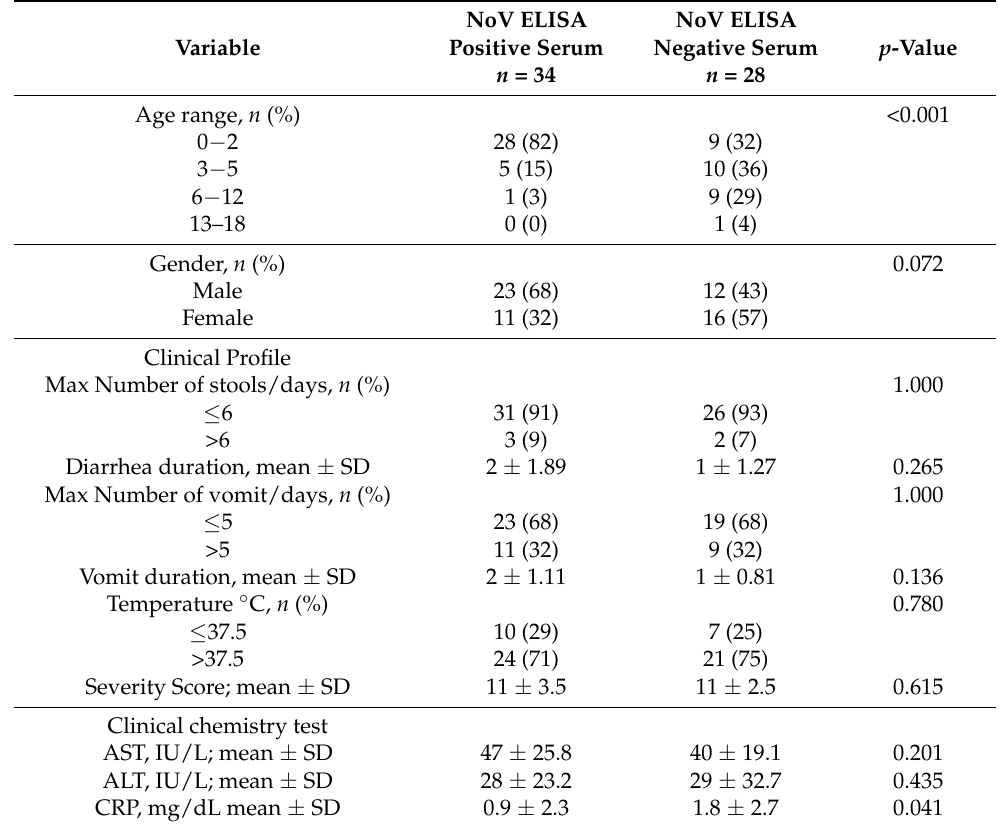
Table 1. Demographics and clinical features of children with/without the NoV-antigen in serum.